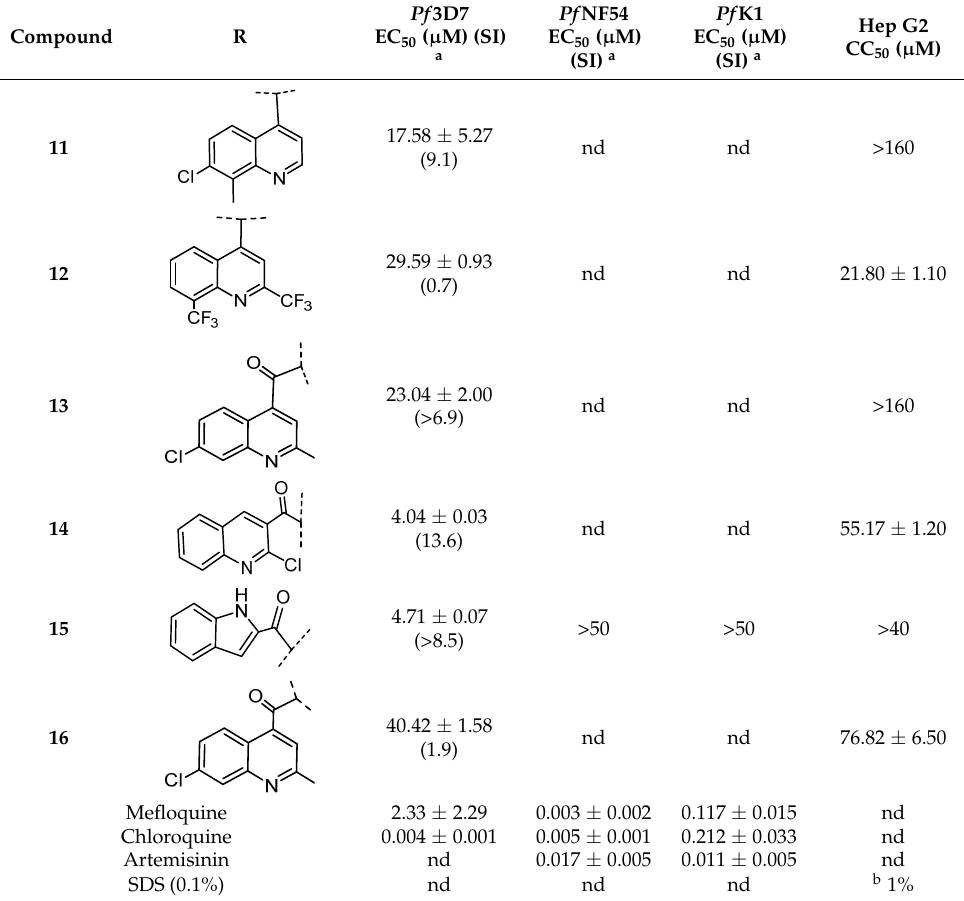
Table 1. Antiplasmodial activity of compounds 1 – 16. Table 2. Antiplasmodial activity of compounds 1 – 16. Table 2. Antiplasmodial activity of compounds 1 – Table 2. Antiplasmodial activity of compounds 1 – 16. Table 2. Antiplasmodial activity of compounds 1 – 16. Table 2. Antiplasmodial activity of compounds 1 – 16 .